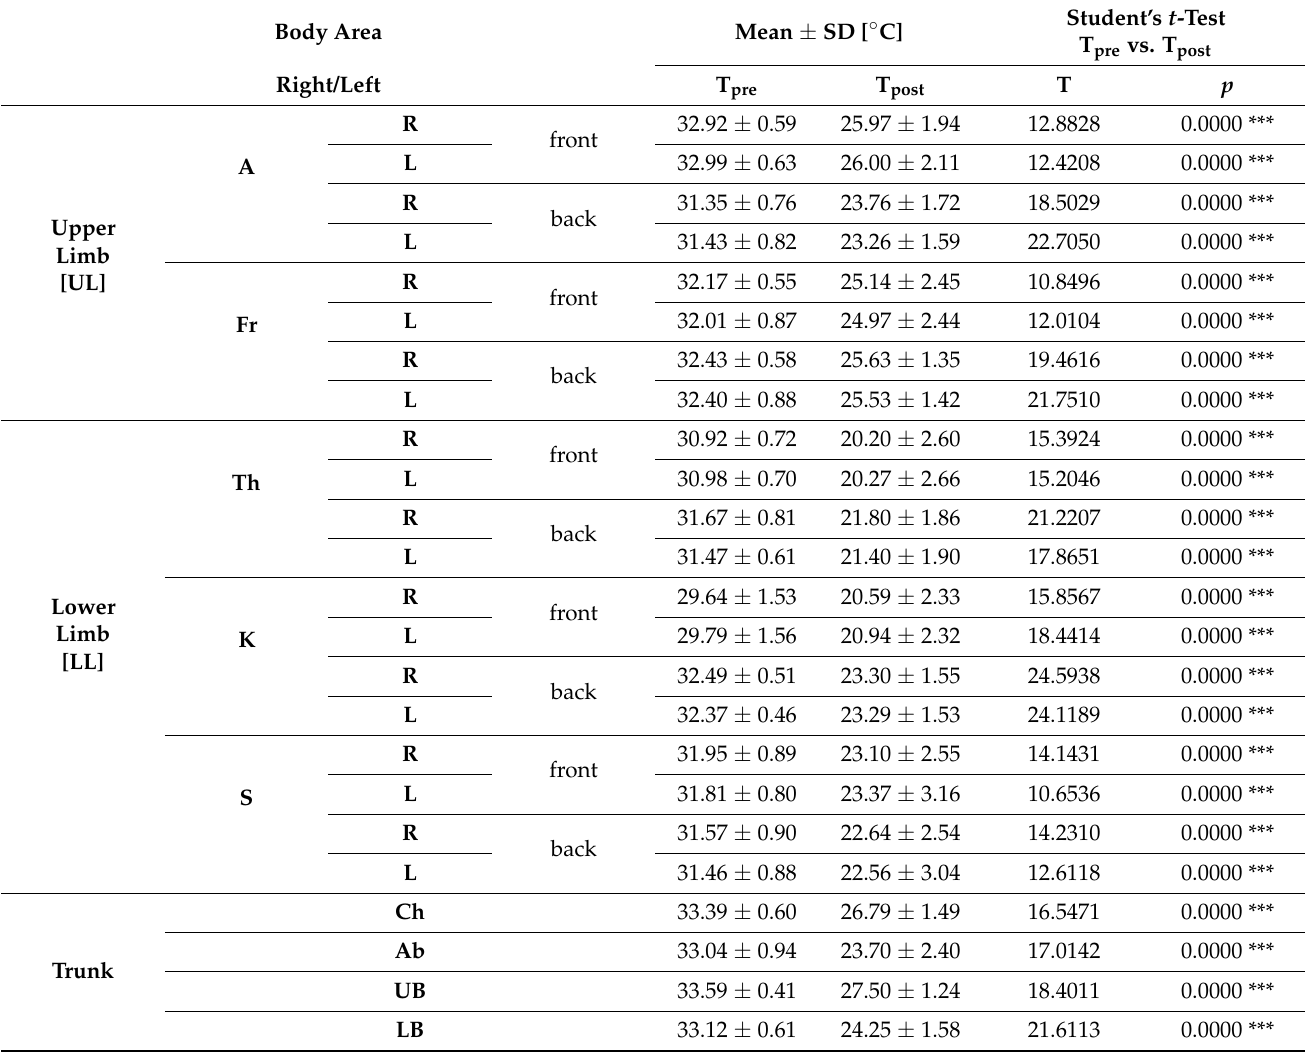
Table 2. Descriptive statistics of the temperature values (T mean ) of the selected body surface areas and the results of the significance tests of differences between the temperature before and after PBC. Body